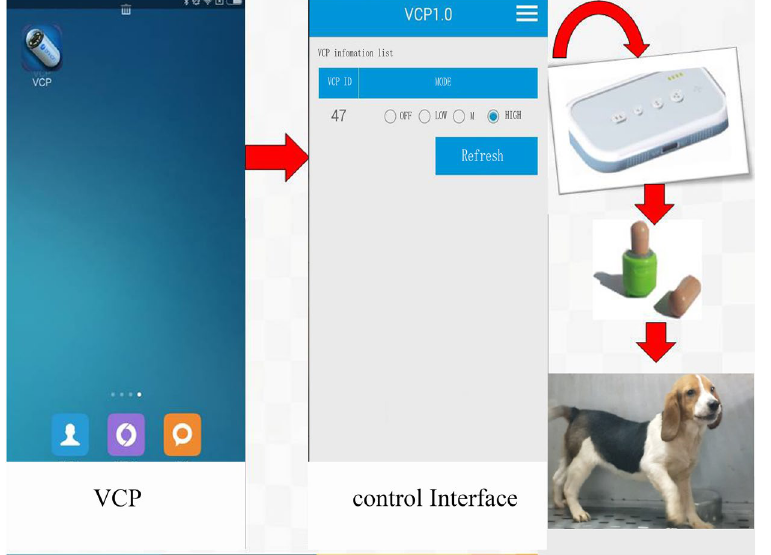
Figure 5. Diagram of vibrating capsule and external configuration